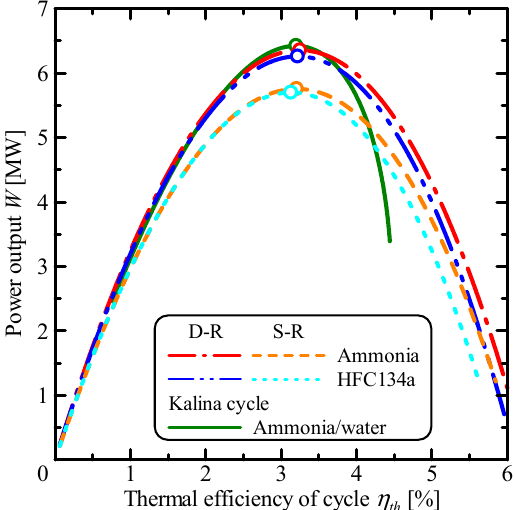
Figure 10. Relationship between the power output and the thermal efficiency of the cycle.